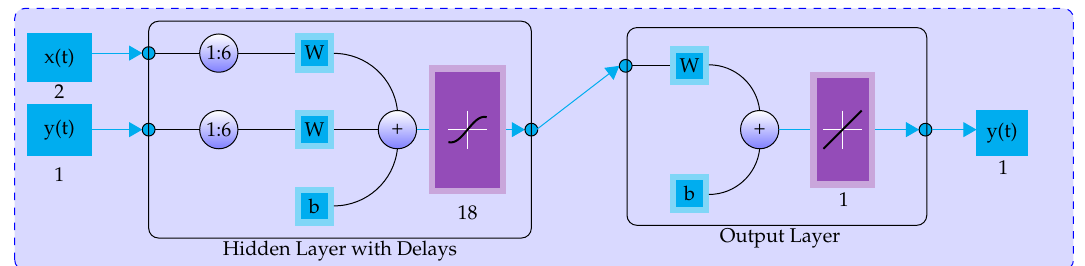
Figure 1. ANN scheme for solar radiation prediction